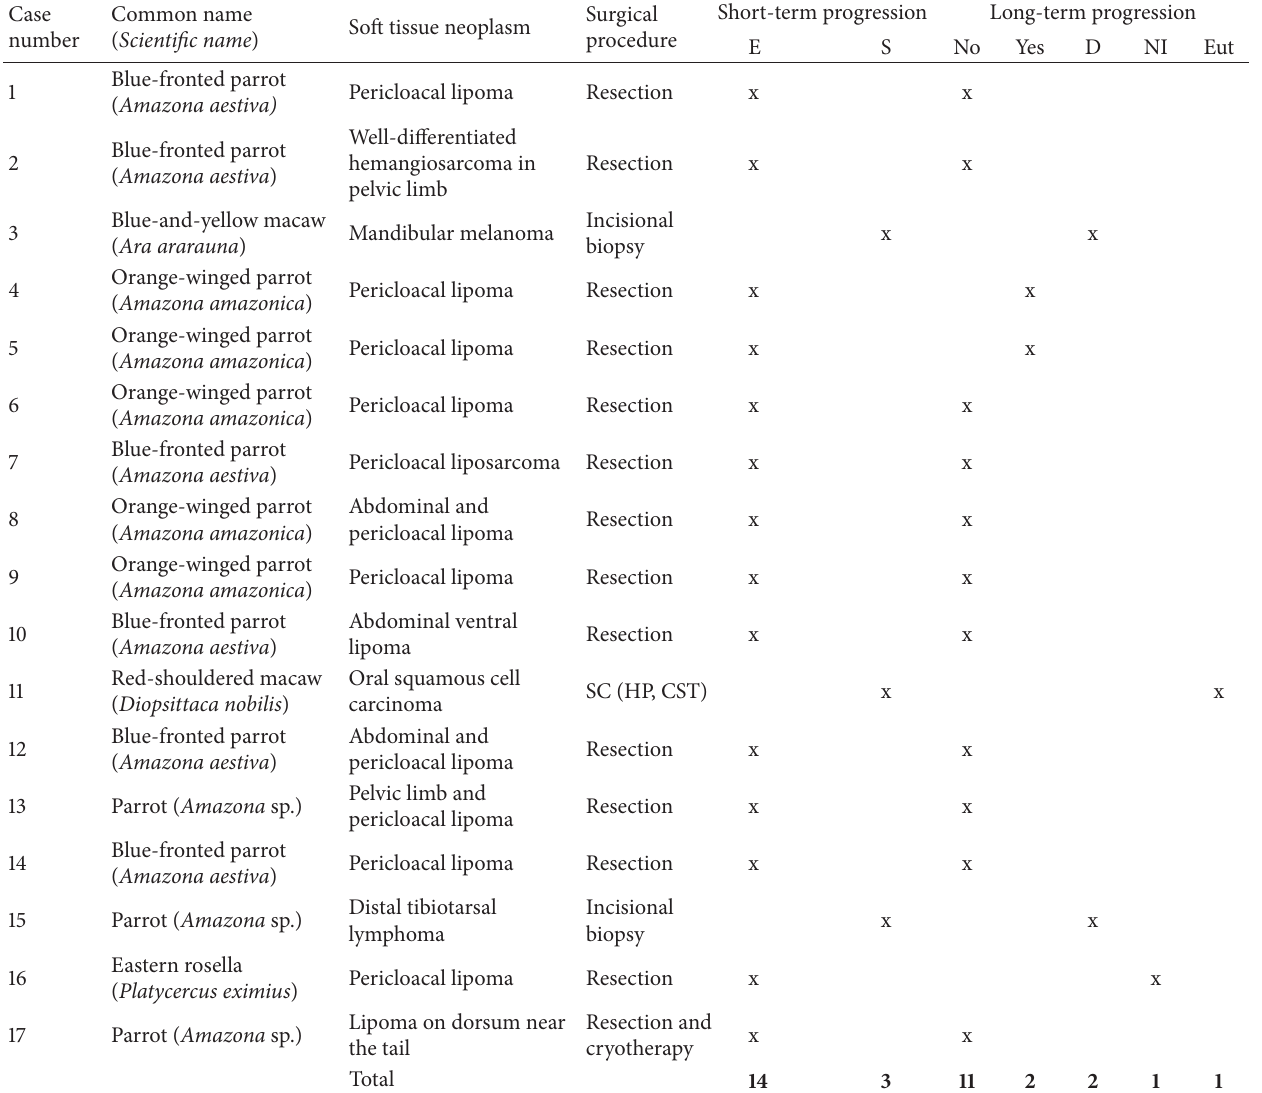
Table 2: Distribution of 17 cases of neoplastic disease operated on between 2000 and 2008 at FMVZ/USP, S˜ao Paulo, Brazil, according to surgical